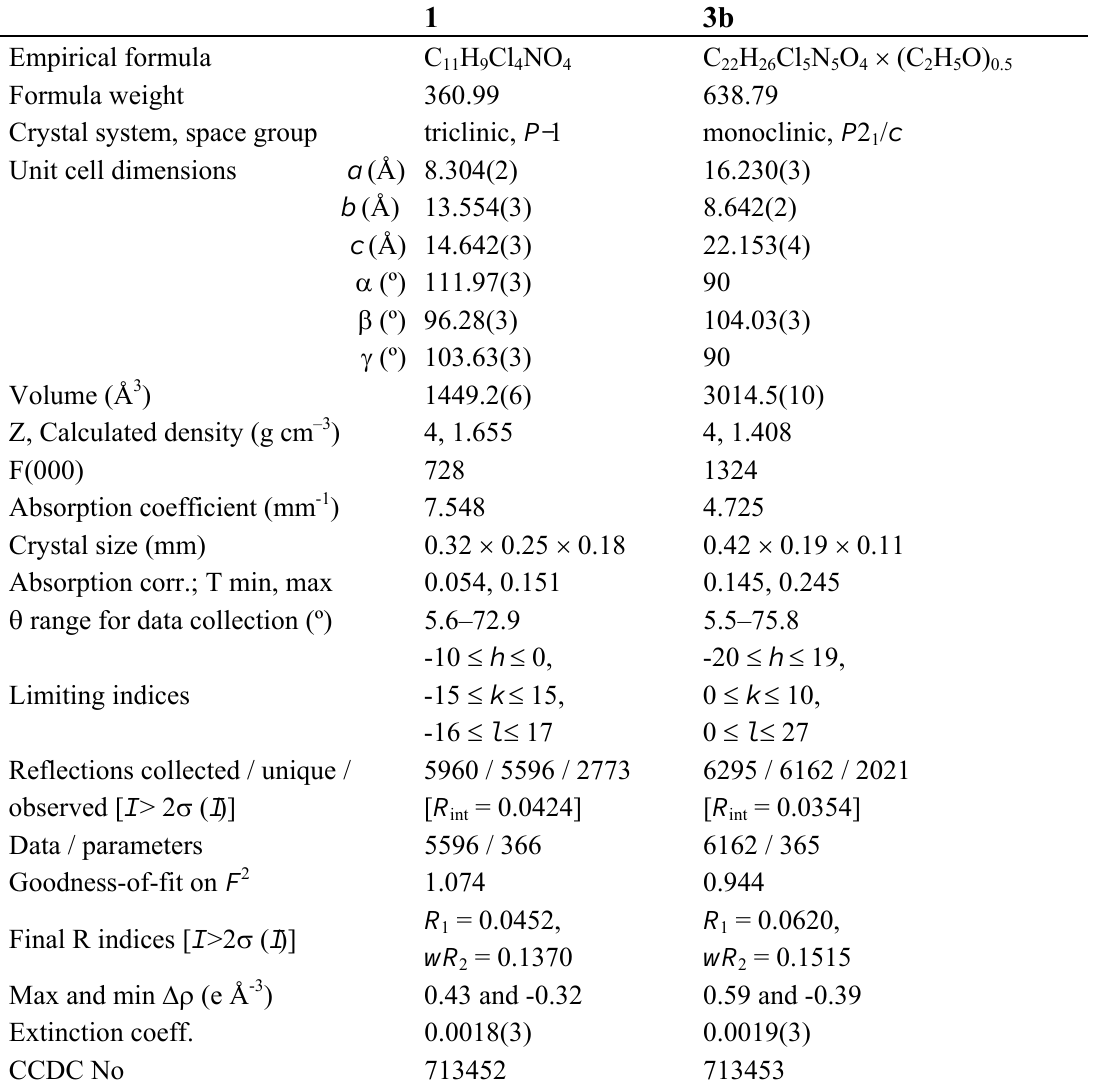
Table 2. Crystal data and refinement parameters for 1 and 3b